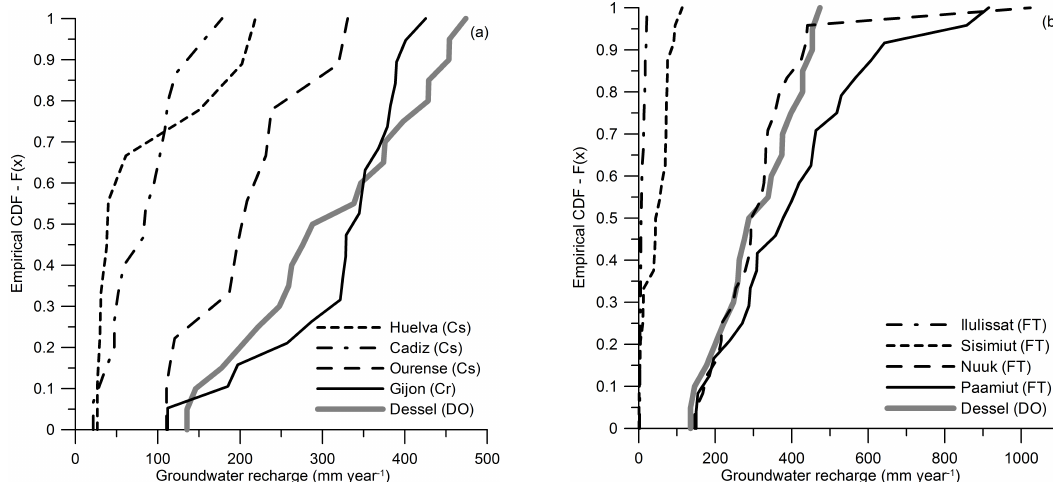
Fig. 1. Cumulative distribution functions of annual groundwater recharge simulated for (a) Cs and Cr and (b) FT analogue stations. The DO reference simulation of the Dessel site is included for comparison.